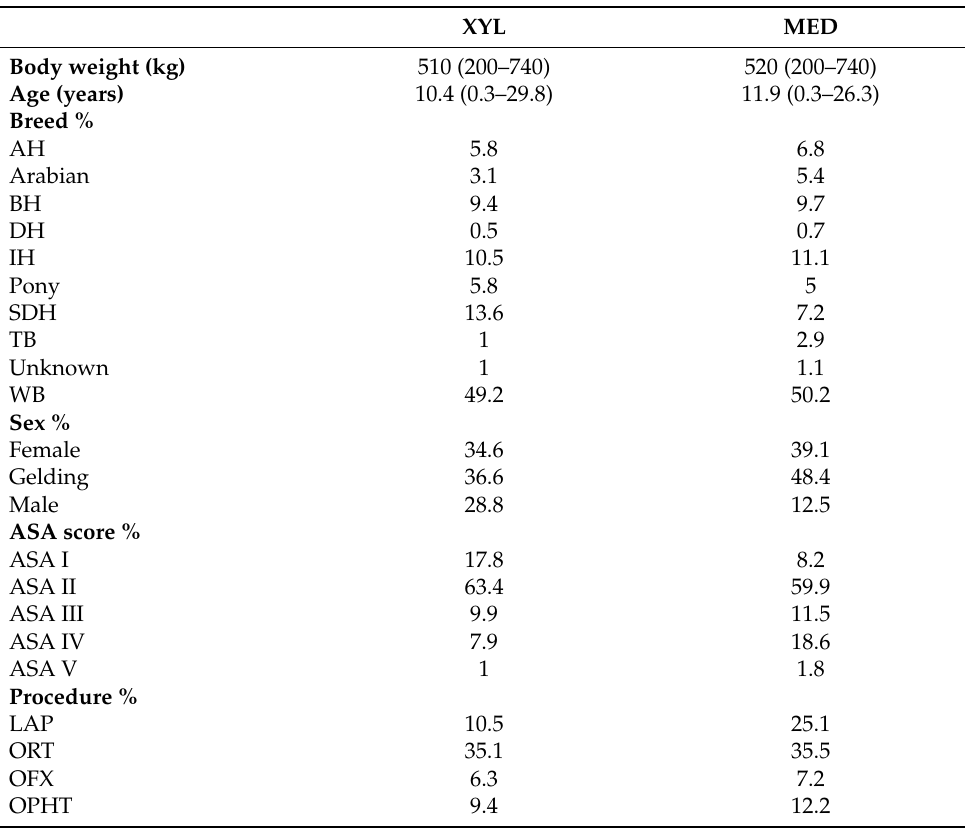
Table 2. Distribution of body weight (median (range)), age (median (range)), breed, sex, American Society of Anaesthesiologists (ASA) score, procedure, emergencies, and surgical positioning between two groups of horses undergoing partial intravenous anaesthesia using isoflurane with either xylazine (XYL, n = 191) or medetomidine (MED, n = 279). AH = American horse, BH = Baroque horse, DH = draught horse, IH = Icelandic horse, SDH = small draught horse, TB = Thoroughbred, WB = warmblood. LAP = laparotomy, ORT = orthopaedics, OFX = fractures, OPHT = ophthalmologic procedures, VISC = visceral surgeries, such as castrations and skin tumour excisions, ENT = surgeries on the head and throat, excluding ophthalmologic procedures, MULT = multiple procedures. RL = right-lateral recumbency, LL = left-lateral recumbency, DR = dorsal recumbency, CH = changing positioning during